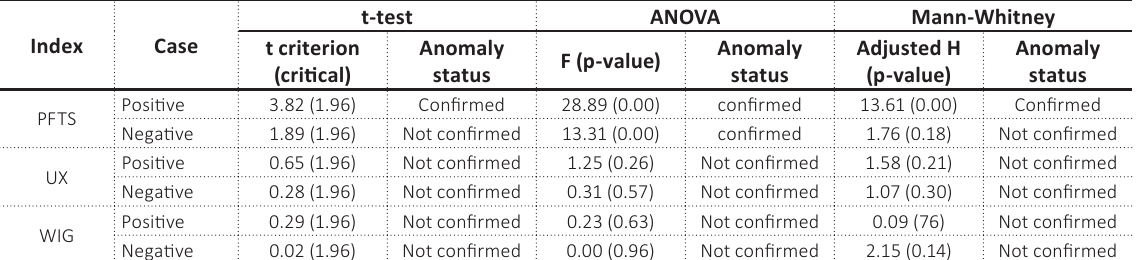
Table 9. Results of tests for differences in returns on days after days with abnormal returns and usual